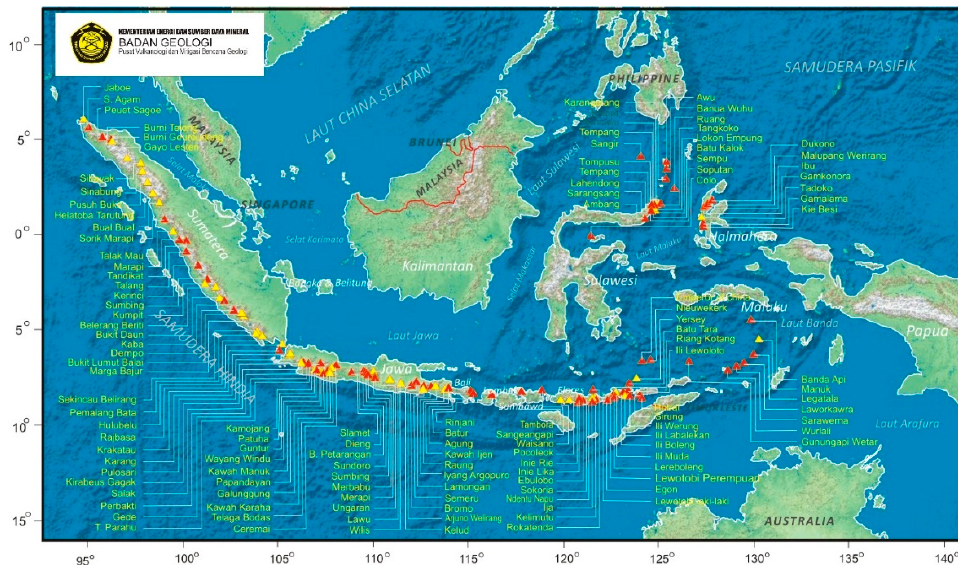
Figure 1. Geographical features of Indonesia archipelago and distribution map of volcanoes in Indonesia [9].